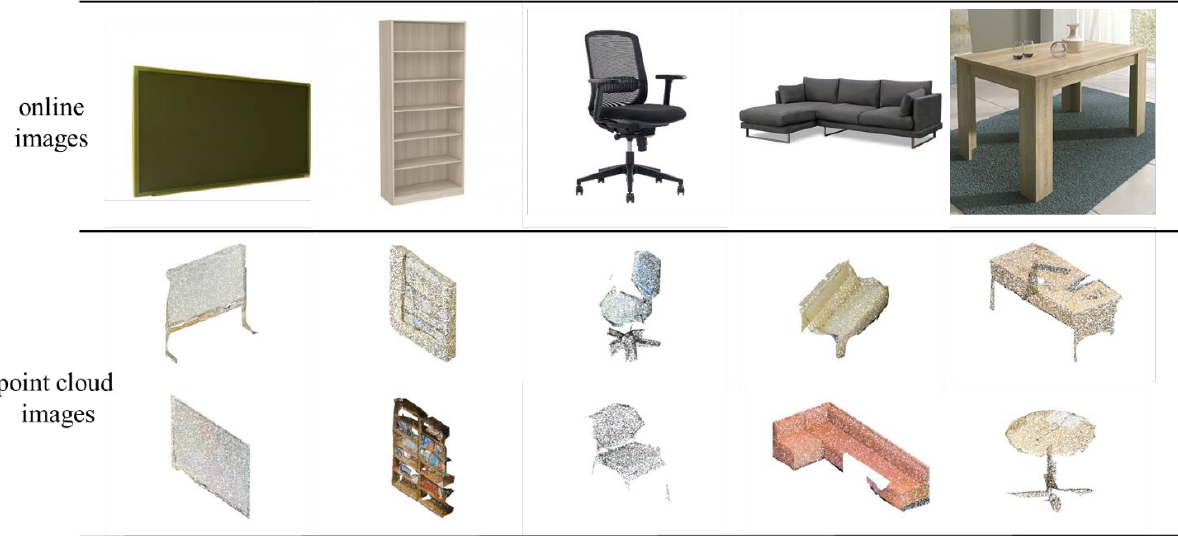
Figure 2. Samples of the five classes: above, images obtained from online sources; below, images obtained from point